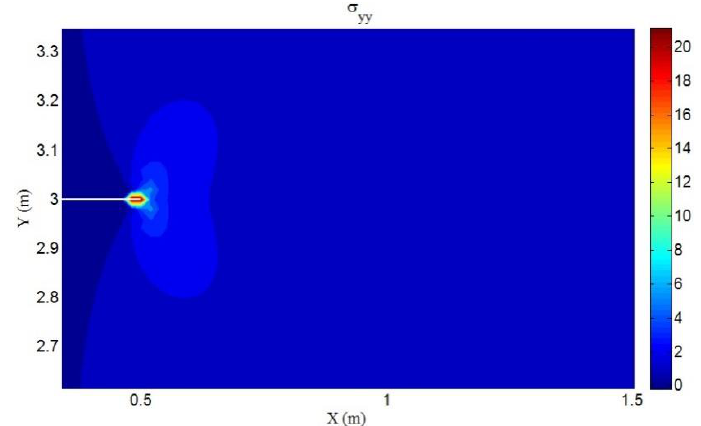
Figure 13. Stress distribution for a plate with a centered edge